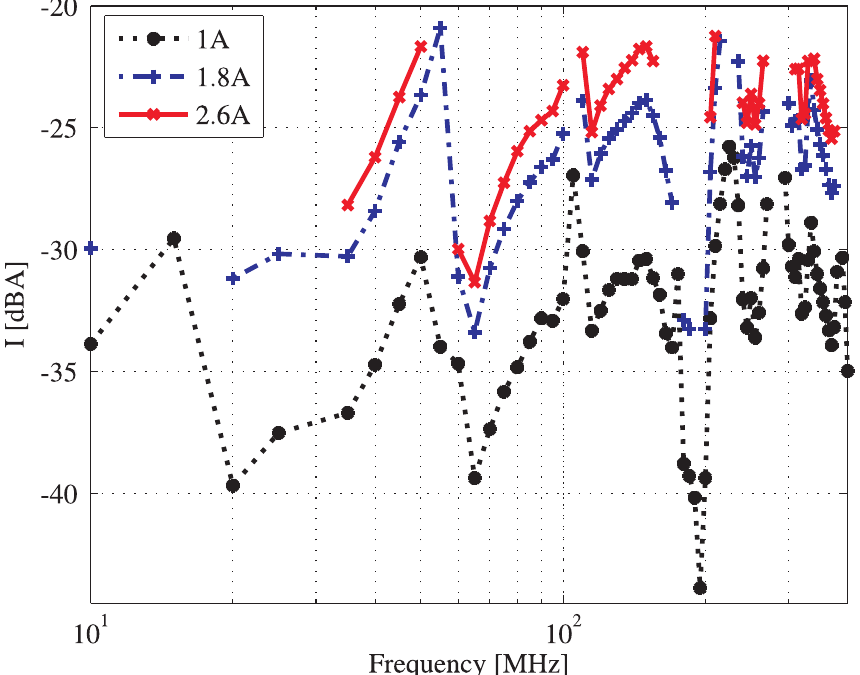
Figure 7. BCI immunity measurement for different current values.